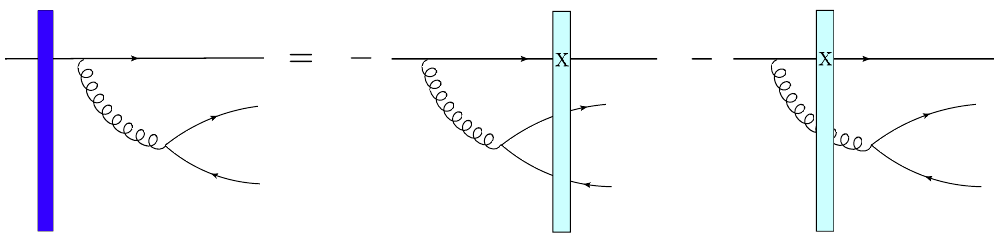
Figure 4 . The new way in which we express the contribution of the initial-state interaction (the middle term in eq. (3.2)) after using the identity eq. (3.3). The light-colour shockwave in the r.h.s. represent the S -matrix (a Wilson line) for the scattering of only one parton: the original quark, denoted with a